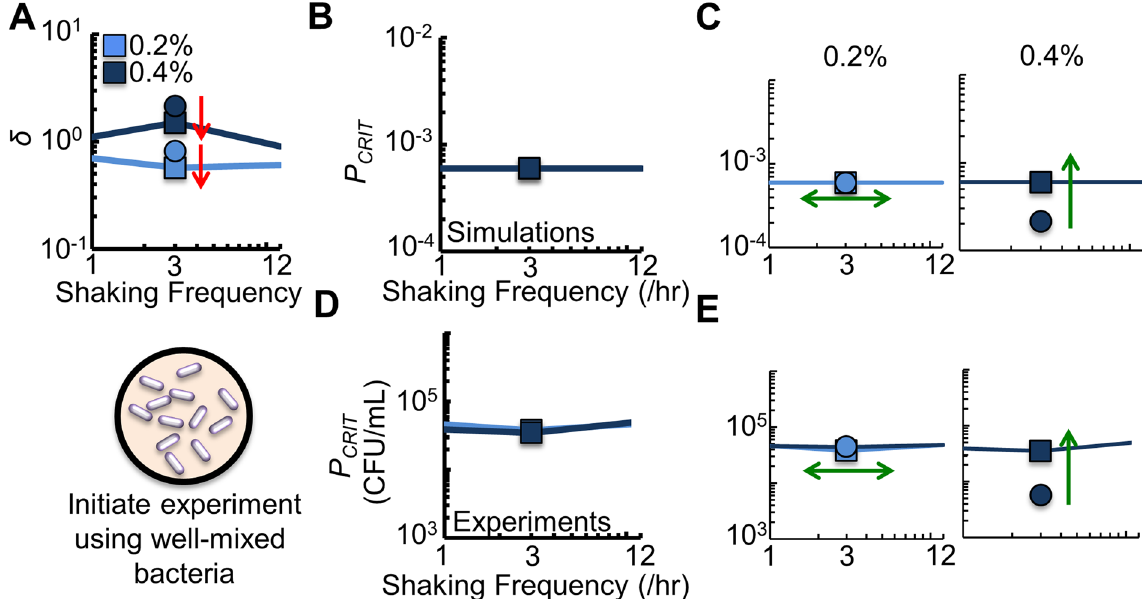
Figure 6. Decreasing access to AHL can increase resistance but reduces cooperation. ( A ) To reduce access to AHL in the model, we decreased δ by 0.7 at 3/hr (relative to δ presented in Fig. 2E). Experimentally, we mixed the bacteria in the well at the beginning of the experiment. For all panels, squares indicate decreased δ . Circles represent data re-plotted from Fig. 4. ( B ) Simulations results (Equations (1–3)) showing P CRIT with decreased δ . For simplicity, we show the three shaking frequencies measured experimentally. ( C ) The result of individual simulations for each shaking frequency examined. For panels (C,E), green arrows indicate resistance increased (single ended arrow) or remained unchanged (double ended arrow). Direction of arrow indicates perturbation to P CRIT . ( D ) P CRIT of engineered bacteria that were initially well-mixed in the microplate well. Two-tailed t-tests for each P CRIT in Supplementary Tables S1 and S2, including comparisons between the well-mixed and non well- mixed initial conditions. SD from a minimum of three biological replicates. ( E ) Individual experiments for each agar density. Raw data in Supplementary Fig.